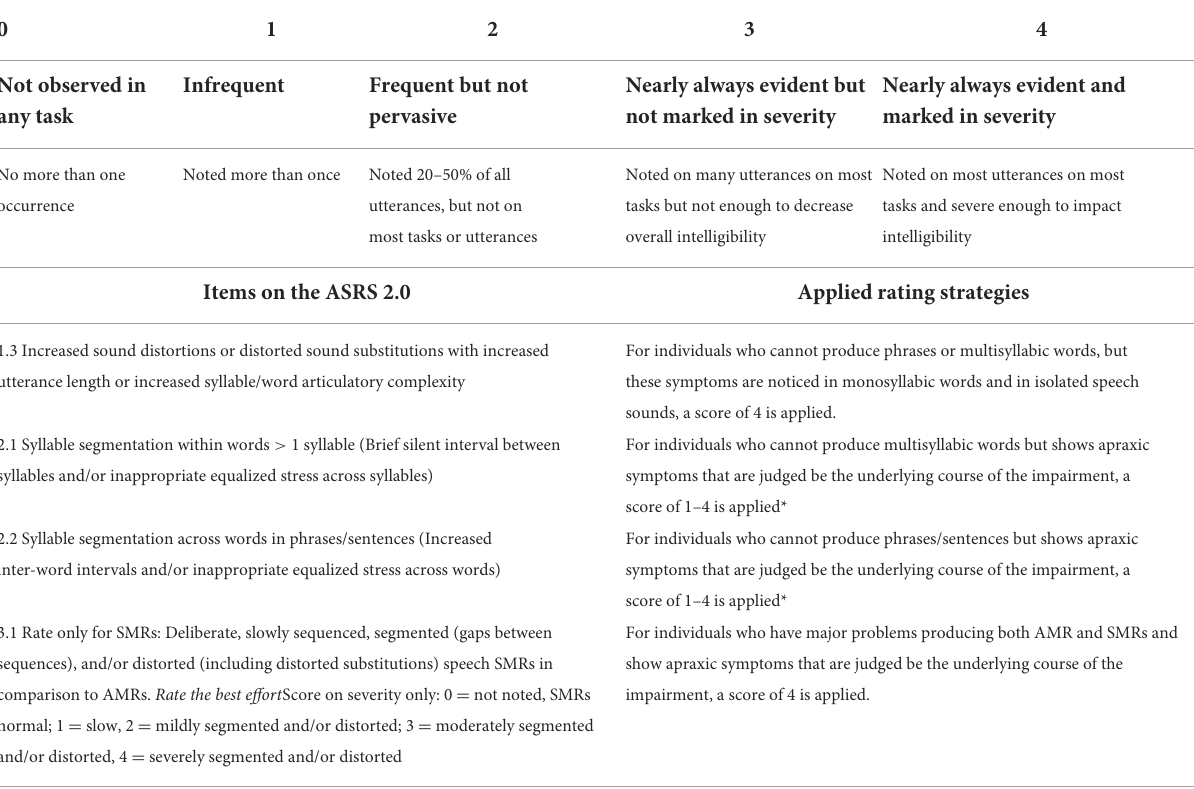
TABLE 1 Modified ratings for participants with limited speech production on the ASRS